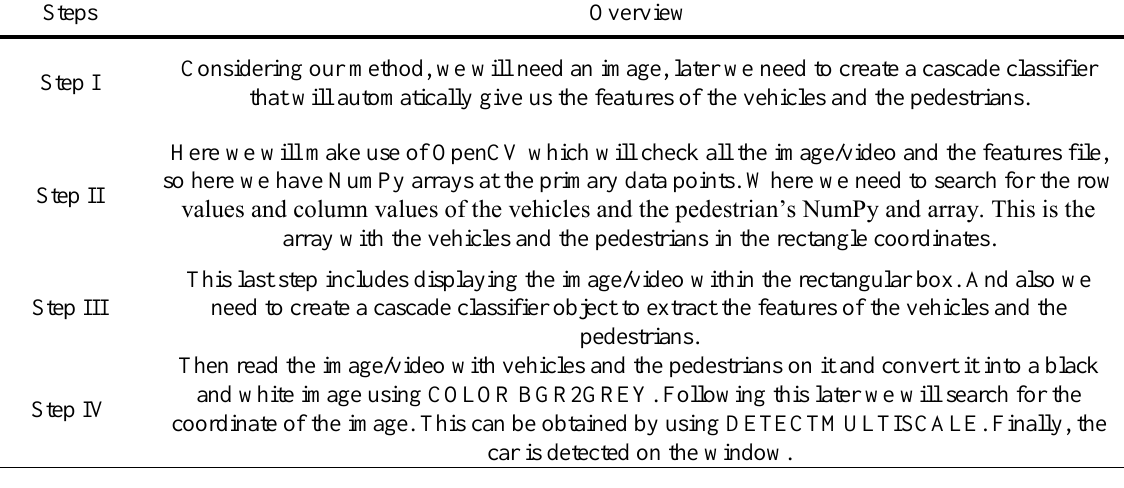
Table 3. Algorithm for proposed